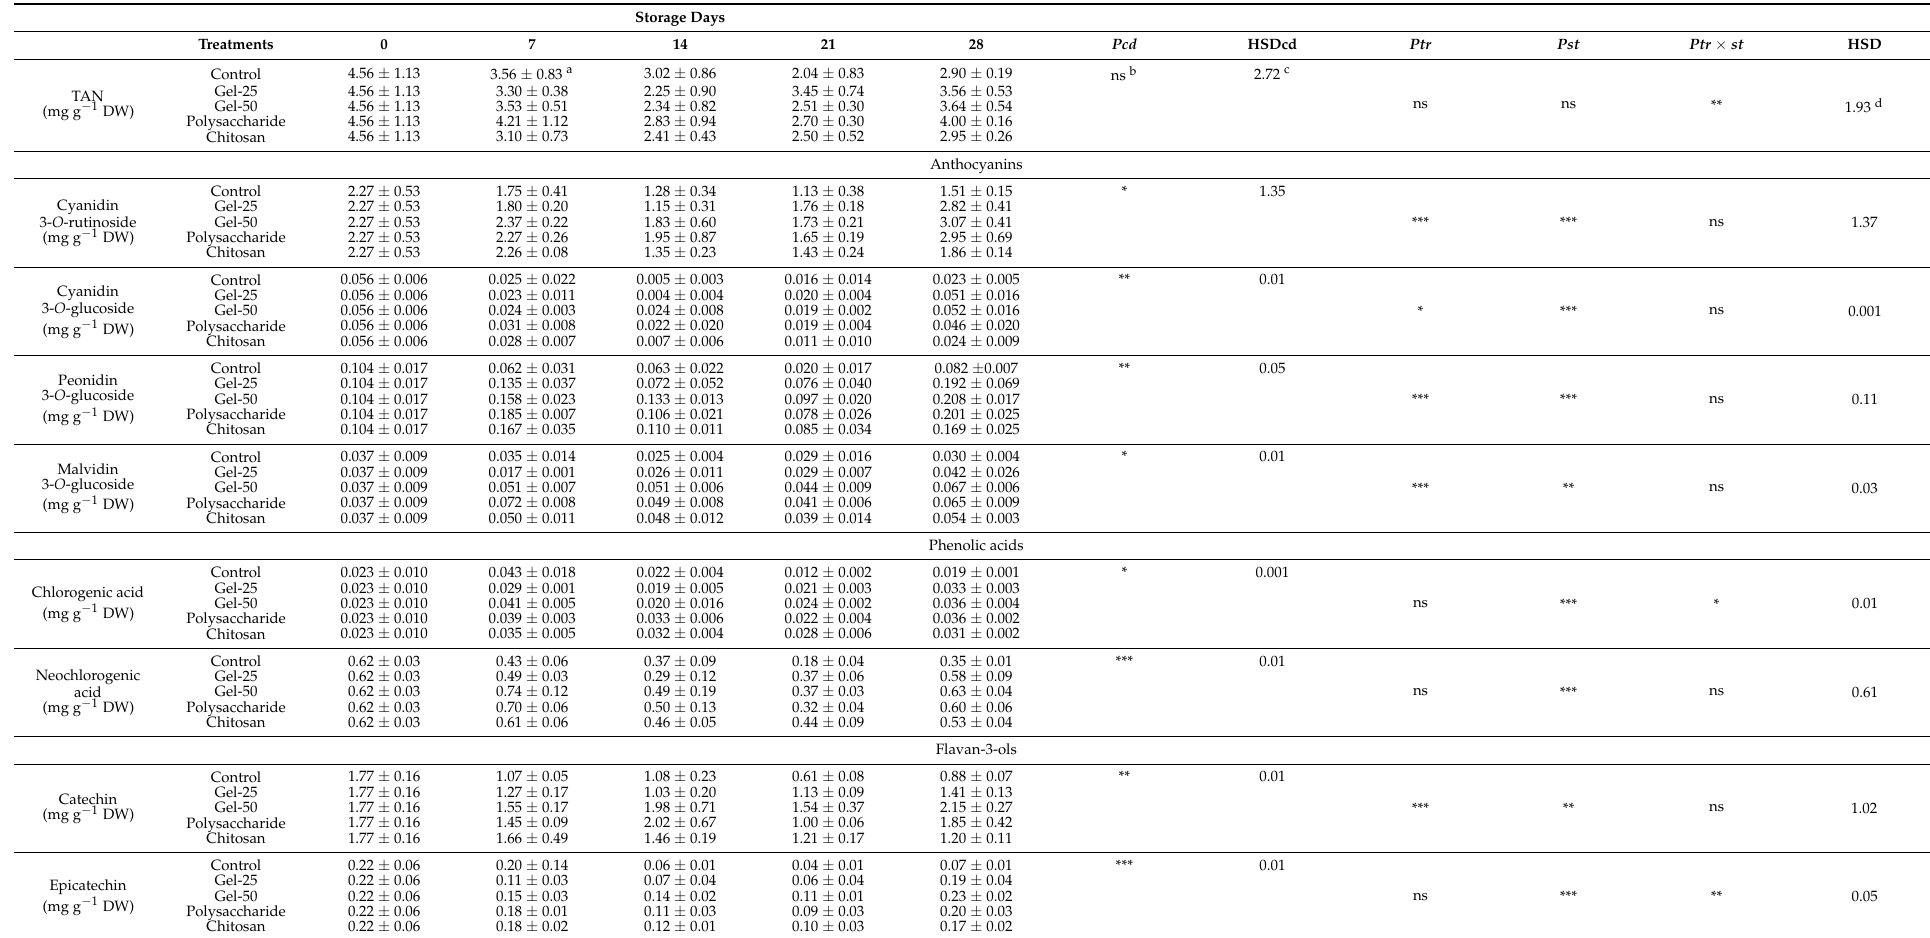
Table 2. Effect of edible coatings on changes in total antioxidant anthocyanin content, on cyaniding-3- O -rutinoside, cyaniding-3- O -glucoside, peonidin-3- O -glucoside, malvidin-3- O -glucoside, chlorogenic acid, neochlorogenic acid, catechin and epicatechin in cherries during